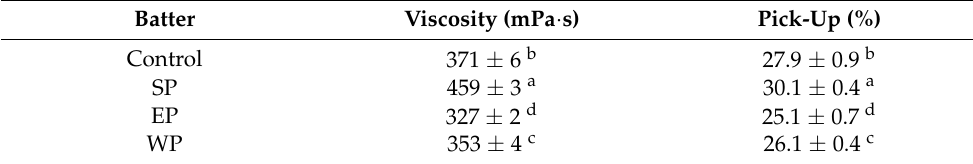
Table 1. Effect of the added proteins on the viscosity of batter and the pick-up of BBFNs. Batter Viscosity (mPa · s) Pick-Up (%)